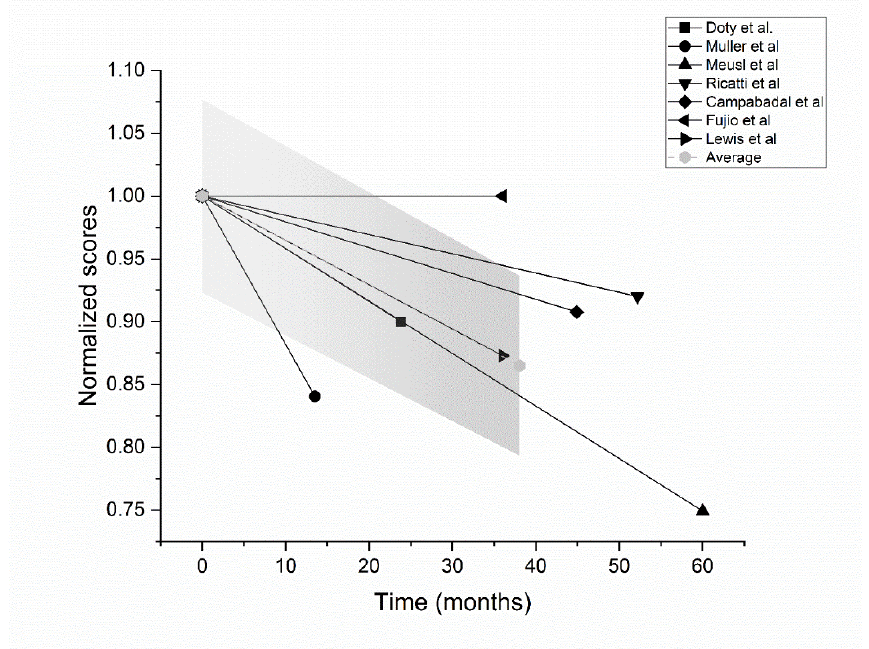
Figure 2. Trend of olfactory function in PD patients considering the studies providing both baseline and follow-up scores. Values from single studies are normalized by dividing them by baseline scores, so that their relative variation from a starting value of 1 is depicted. Black solid lines represent data from single studies, while their average is indicated by the grey dashed line. The grey shaded area represents the standard error of the mean.